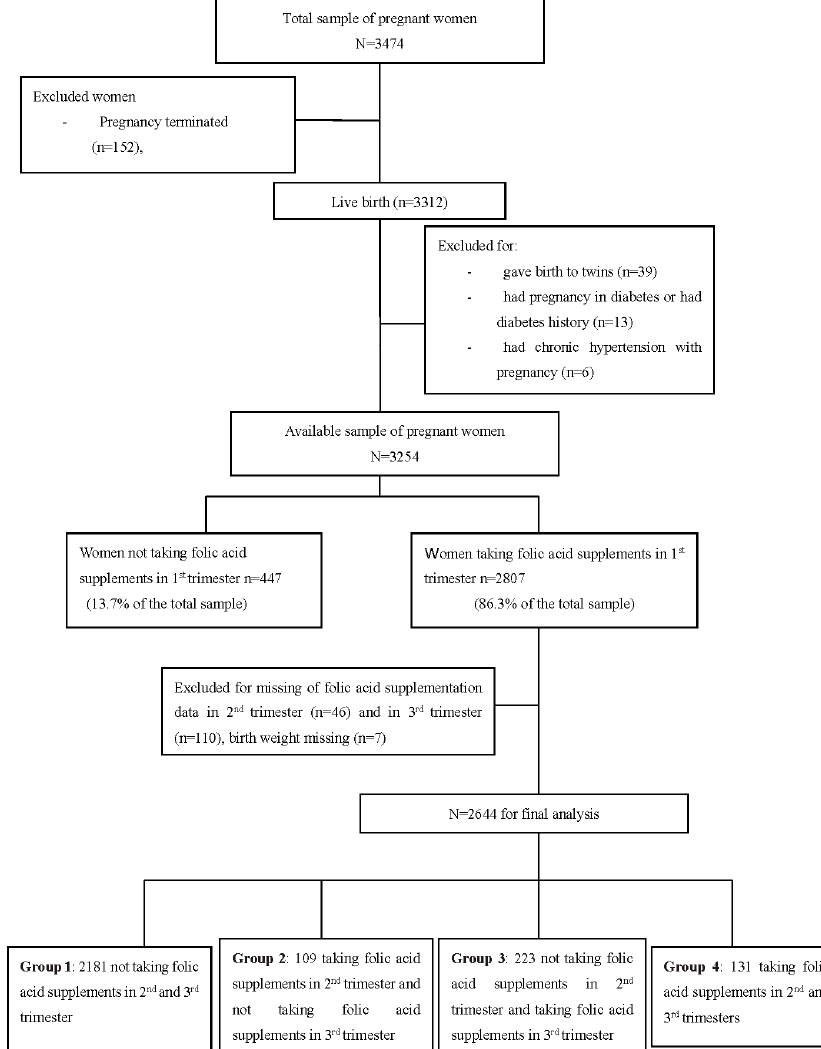
Figure 1. Flow diagram of recruitment and follow ‐ up in this birth cohort study.